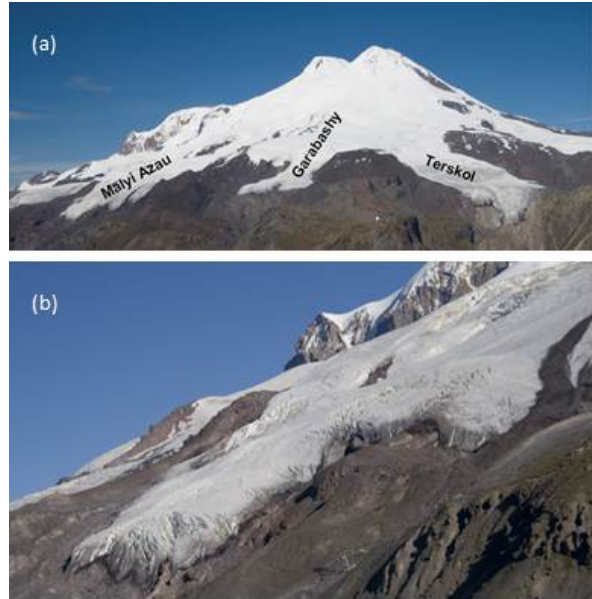
Figure 2. Oblique aerial photograph of (a) glaciers on Mt. Elbrus and (b) snout of the Malyi Azau glacier. Note the clearly defined glacier boundaries and a very limited extent of debris cover. Photo- graph by I. I. Lavrentiev (25 August 2009).